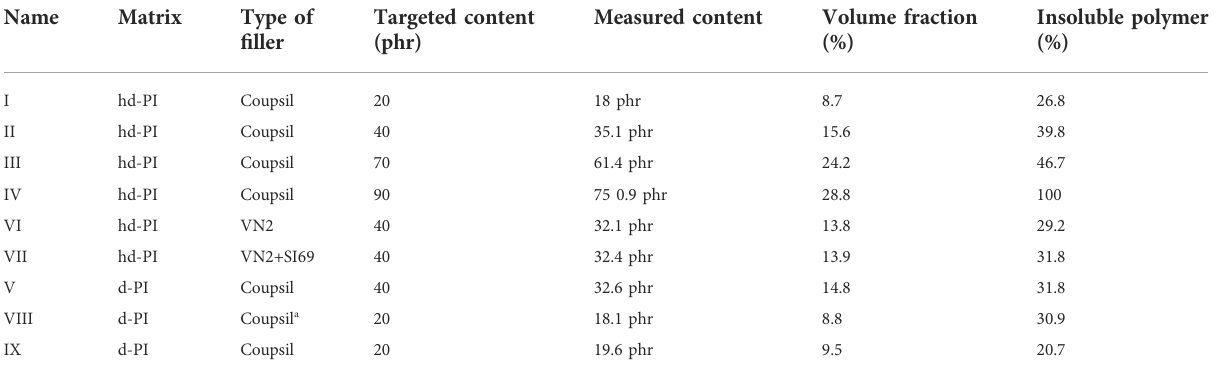
TABLE 1 List of